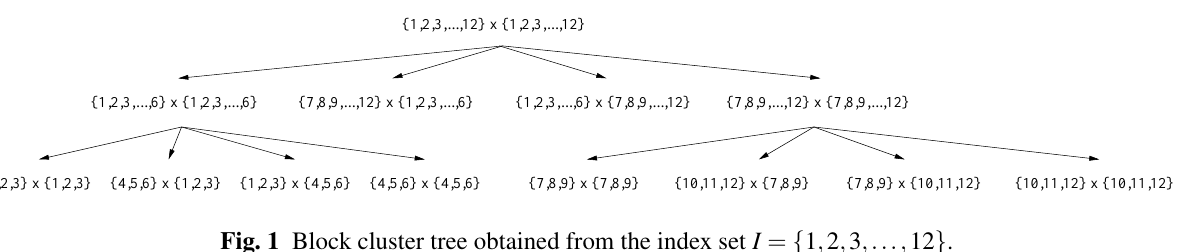
Fig. 1 Block cluster tree obtained from the index set I = { 1 , 2 , 3 ,..., 12 } .